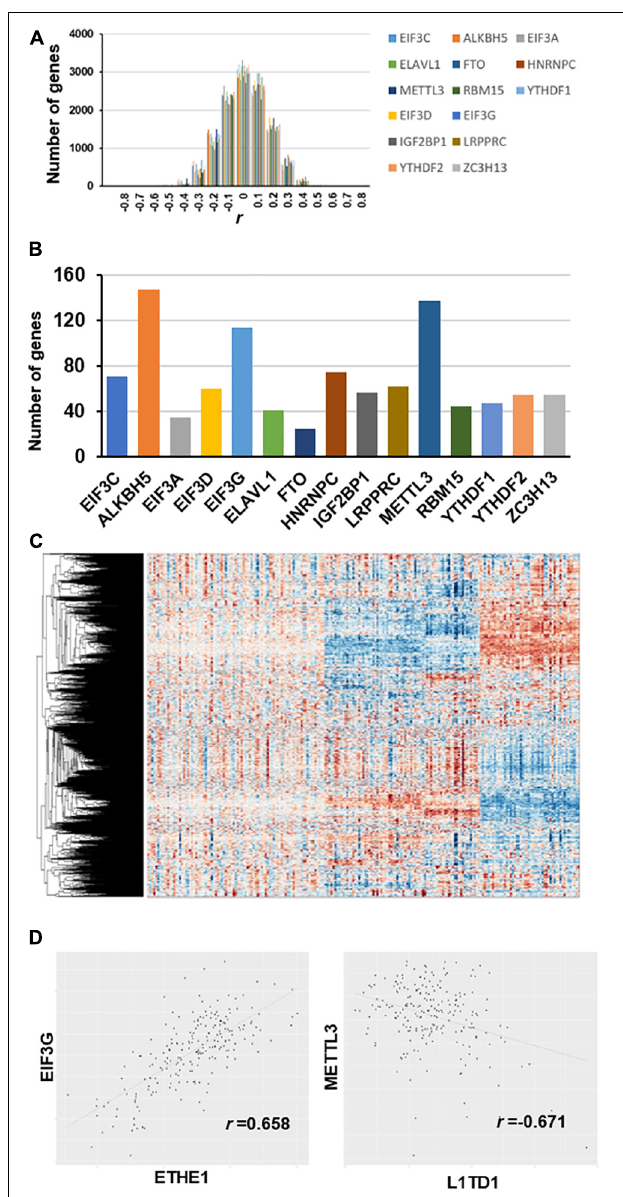
FIGURE 2 | Co-expression between genes and m 6 A regulators after removal of diabetes related gene effects. (A) Distribution of partial correlation coefficient. The correlation coefficient distribution ranged from 0.658 to –0.671. (B) Number of genes co-expressed with each m 6 A regulator ( r > 0.35). (C) Transcriptome heatmap of differential co-expressed genes in control versus T2DM islet β -cells. (D) Scatterplot of gene expression with top value of partial correlation